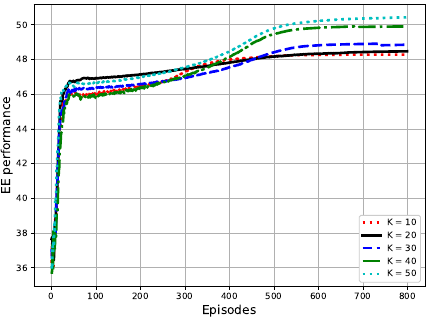
Figure 6. The network sum-rate while using the PPO